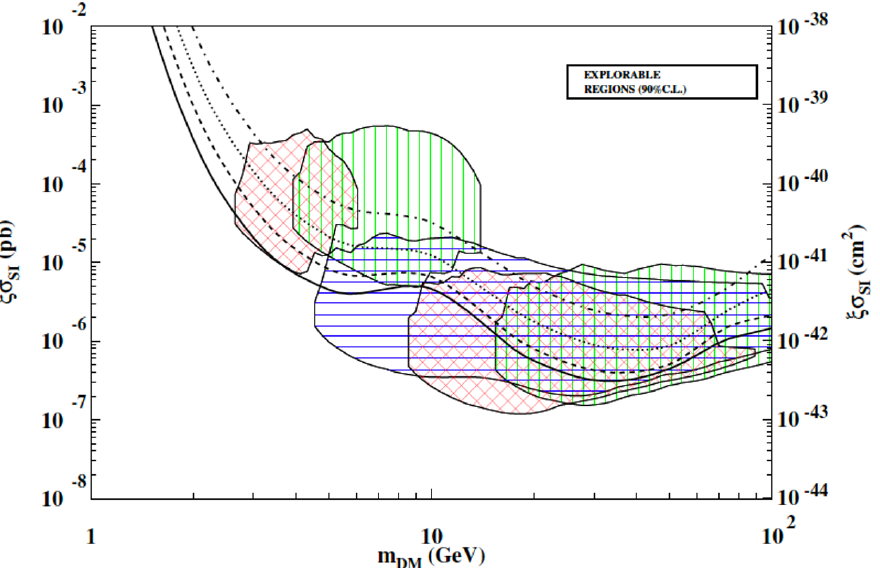
Figure 7. Sensitivity curves (black, ξσ p vs the dark matter (DM) particle mass, m DM ) at 90% C.L. reachable by the ADAMO project for DM candidates inducing nuclear recoils exploring the directionality approach [48]. The software energy thresholds is assumed 2 keVee; other choices are reported in [48]. Four possible background levels in the low energy region are considered: 10 − 4 cpd/kg/keV (solid black lines), 10 − 3 cpd/kg/keV (dashed lines), 10 − 2 cpd/kg/keV (dotted lines) and 0.1 cpd/kg/keV (dotted-dashed lines). For comparison, also shown are the allowed regions obtained in [45] by performing a corollary analysis of the model-independent result after the first six annual cycles of DAMA/LIBRA–phase2 in terms of scenarios for DM candidates inducing nuclear recoils. Three different instances for the Na and I quenching factors have been considered (different colored and hatched allowed regions); for details see